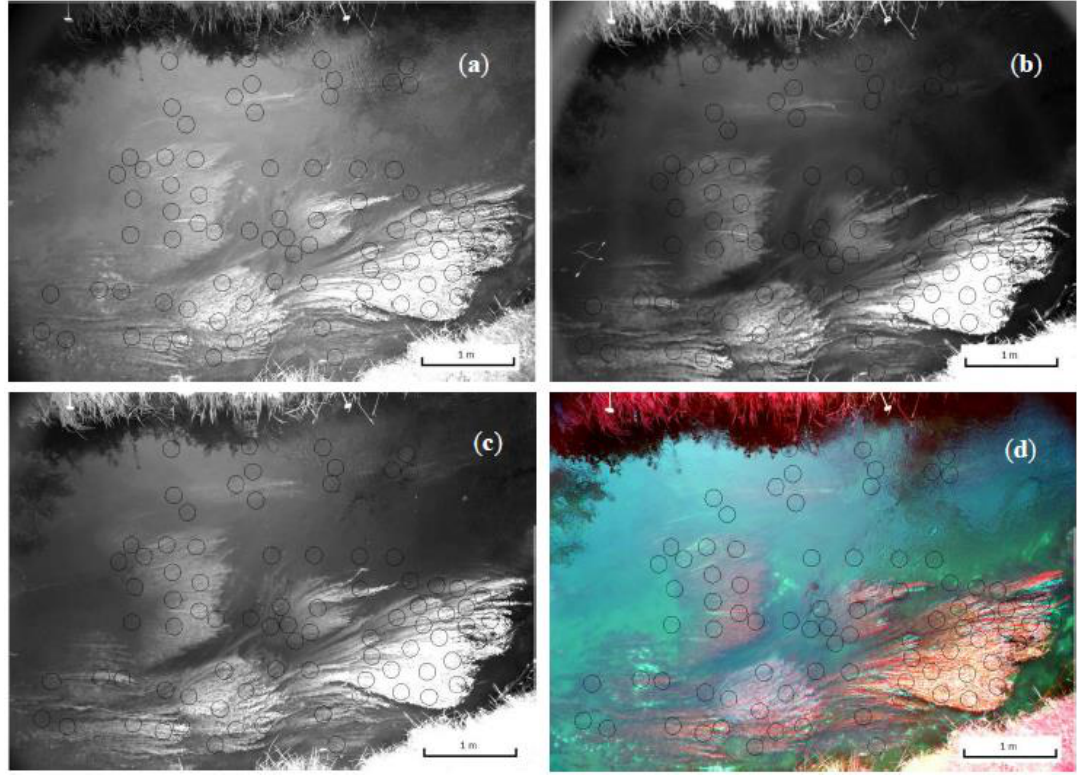
Figure 4. Image (composite) bands for site 1b: ( a ) NIR(BP1); ( b ) NIR(BP2); ( c ) NIR(R72); ( d ) False colour composite based on R, G, and NIR(R72). Black circles indicate depth/DN sample